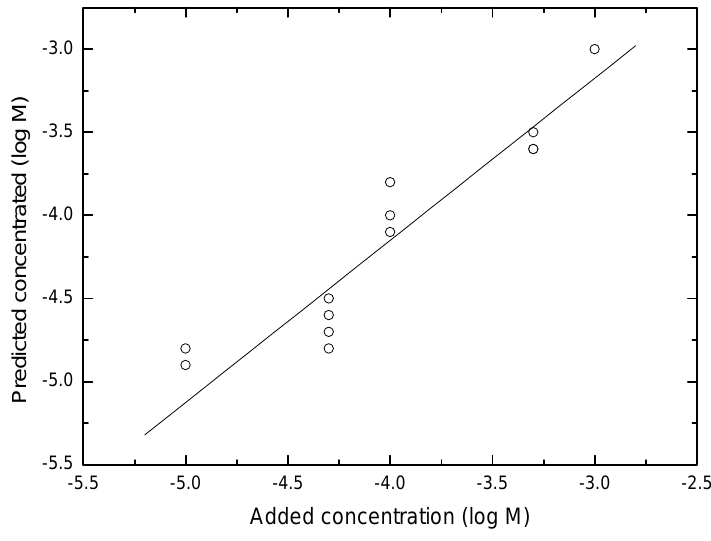
Figure 5. Calibration curve (18 samples) of n-butyrate at pH 6. BPNN used 6, 8, 1 nodes. Concentration of ammonium was below 5 × 10 -4